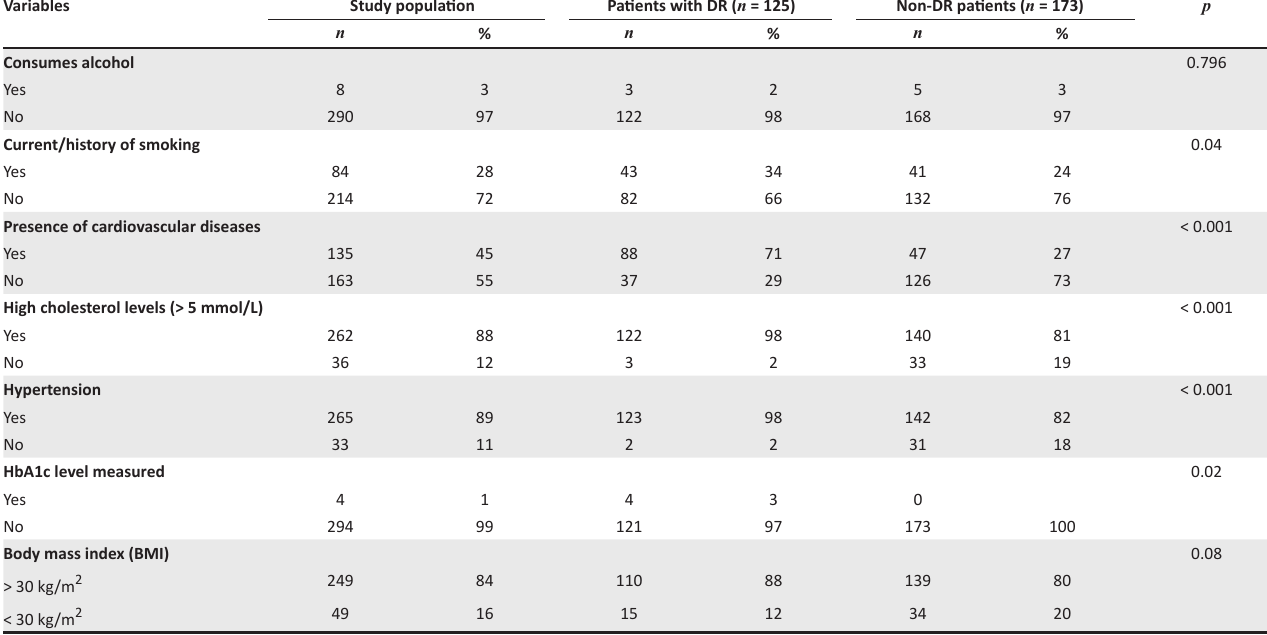
TABLE 2: Frequency table of the clinical profile of study population and diabetic retinopathy patients.